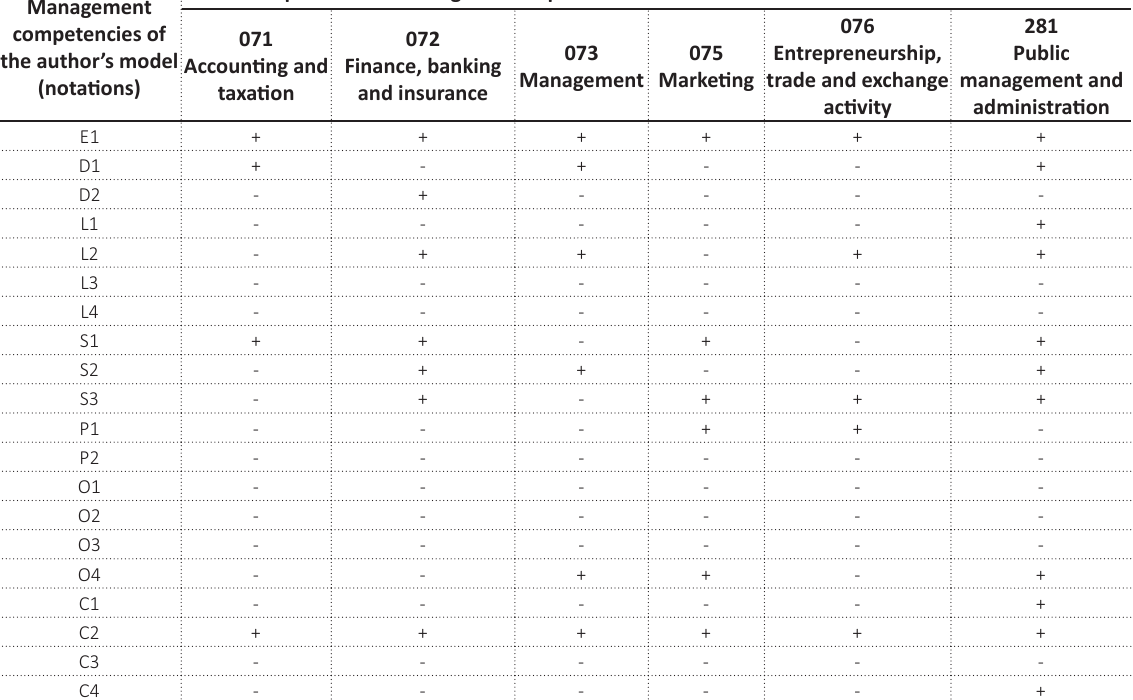
Table A6. Comparison of the management competencies of the study model and those available in Standards by fields of knowledge 07 “Management and administration” and 28 “Public management and